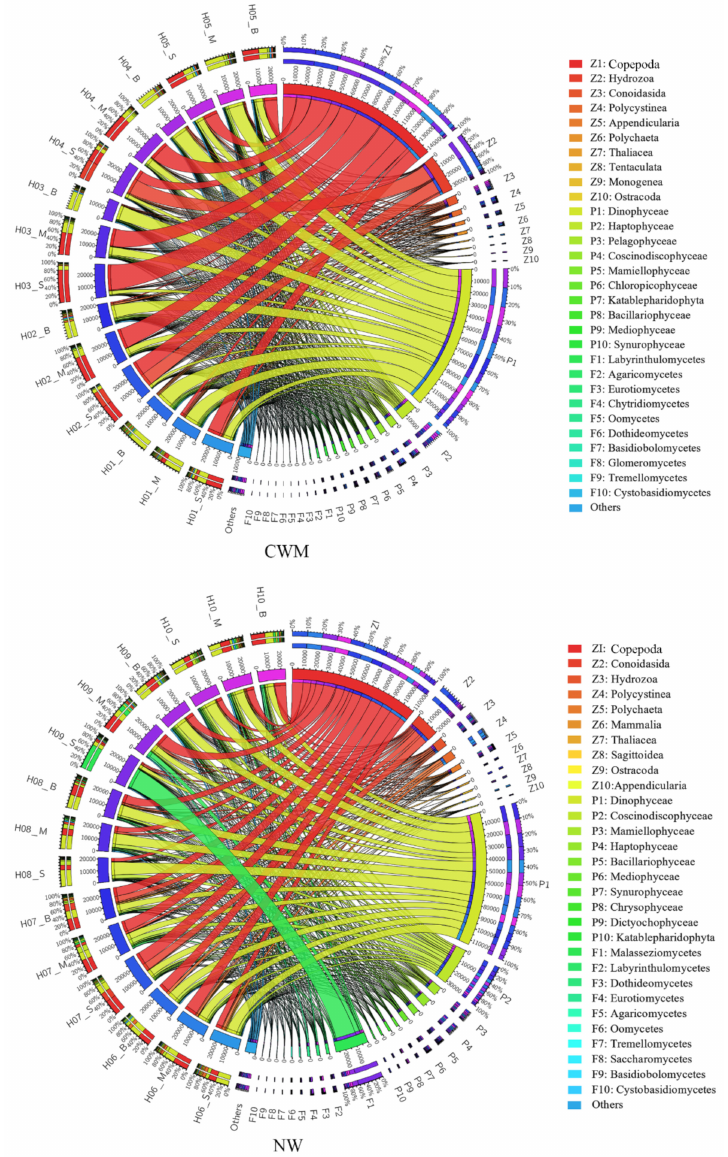
Figure 3. Circos figure revealing the ten zooplankton, phytoplankton and fungi with the highest relative abundance among the classes in different waters of the South Yellow Sea. (CWM: Cold Water Mass; NW: nearshore waters; F: fungi; P: phytoplankton; Z: zooplankton). The dominant OTUs at the family level of each sample point in the CWM and NW were compared with each other (Figure 4). We found Malasseziaceae, Sarcocystidae, Skele- tonemataceae, Harpacticidae, Cryptomonadaceae, Suessiaceae, Cymatosiraceae, Stephan- odiscaceae and Miraciidae had greater relative abundance in NW than in the CWM. How- ever, in the CWM, Chloropicaceae, Peridiniaceae, Phaeocystaceae, Katablepharidaceae, Warnowiaceae, Prymnesiaceae, Chrysochromulinaceae and Oikopleuridae showed higher relative abundance than in NW. Adeleidae, Plagoniidae, Glenodiniaceae and Stephanoeci- dae were predominantly found in the CWM–M and CWM–B, and the relative abundance of the CWM–B was greater than that of the